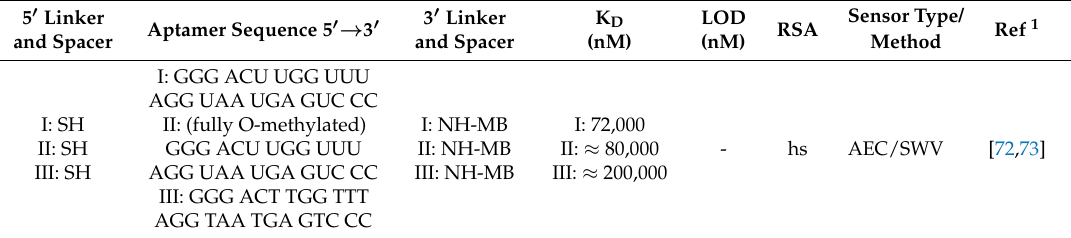
Table 3. Aptamer sequence, dissociation constant (K D ), limit of detection (LOD), real sample analysis (RSA), and realized sensor type and measuring method for gentamicin, mentioned in the corresponding references (Ref). AEC = amperometric electrochemical, hs = human serum, MB = methylene blue, and SWV = square wave